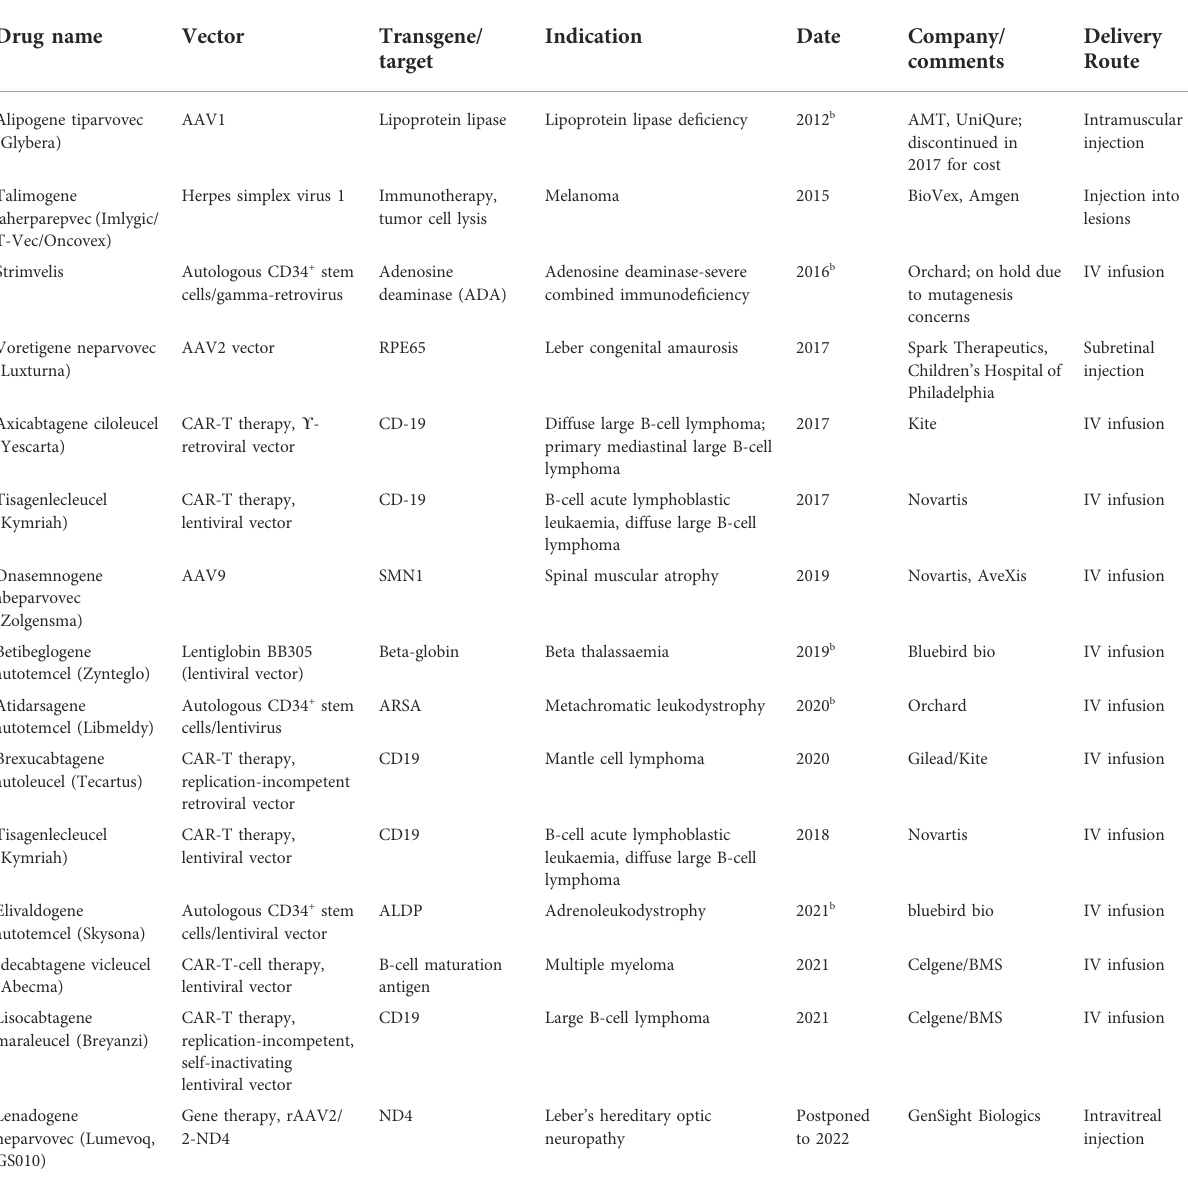
TABLE 2 Gene therapy treatments approved by FDA and/or EMA a . Drug